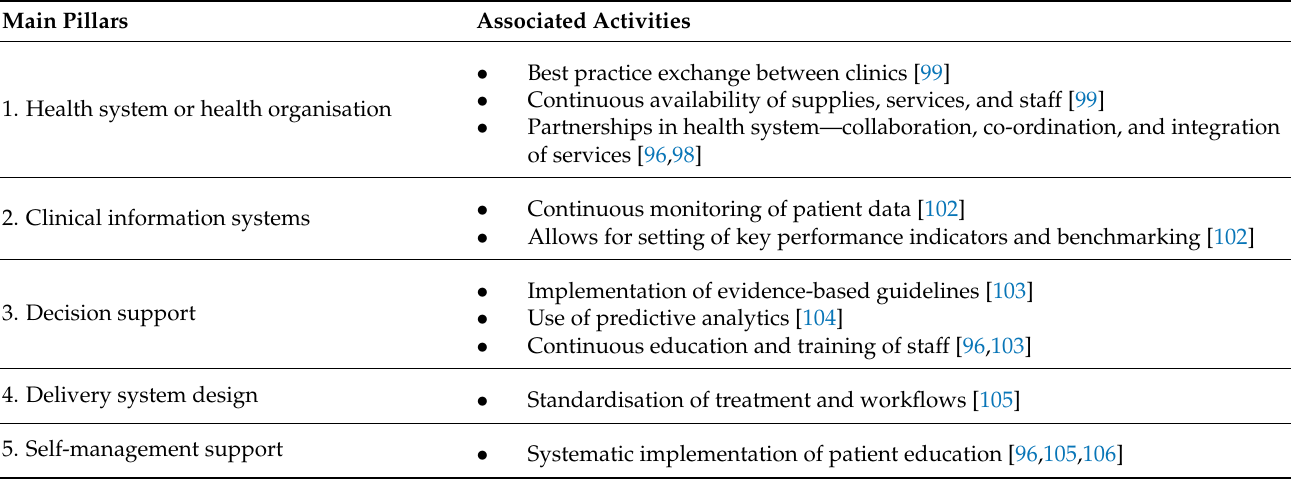
Table 3. The main pillars of care networks and associated